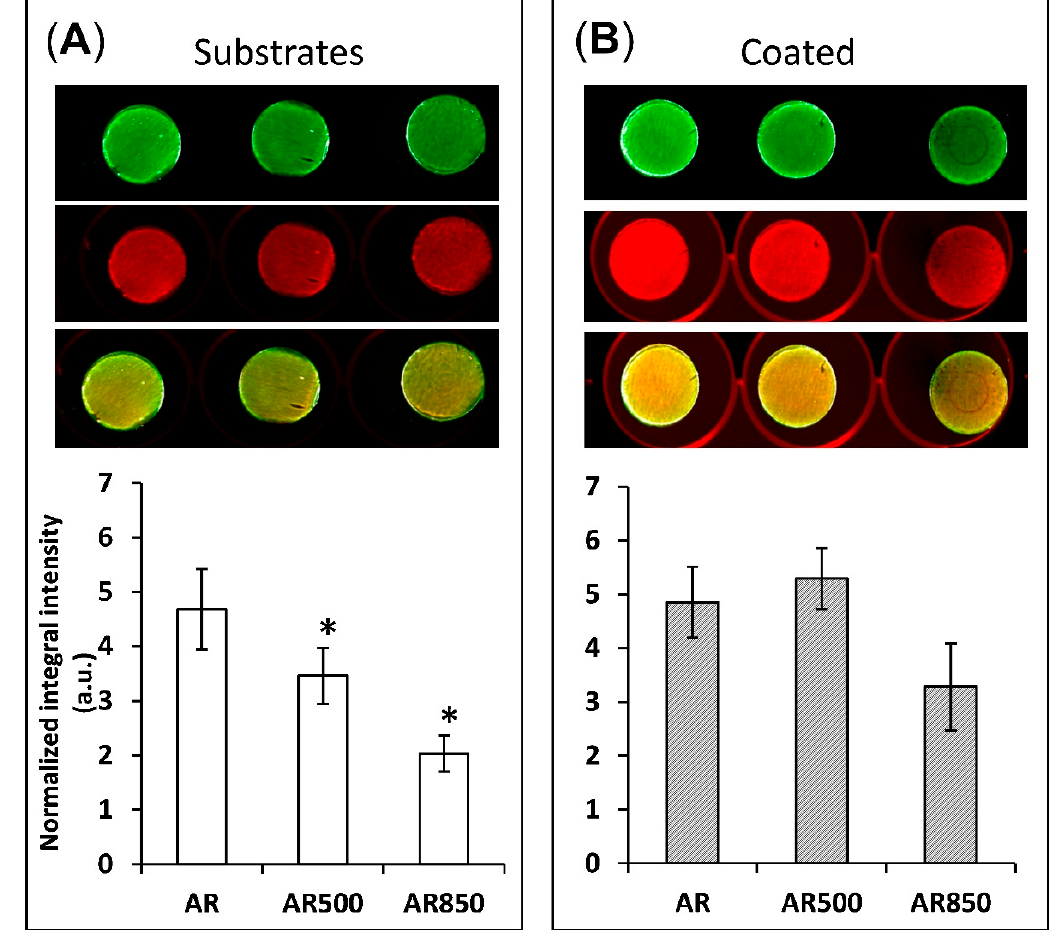
Figure 13. Bone mineralization activity of ( A ) uncoated and ( B ) coated samples after 31 days post-seeding of MG63 cells. * p < 0.01 compared to the AR sample. Mineralization was visualized by BoneTag CW800 (green) and cells by CellTag700 (red). * p < 0.05 compare to AR, n = 3.